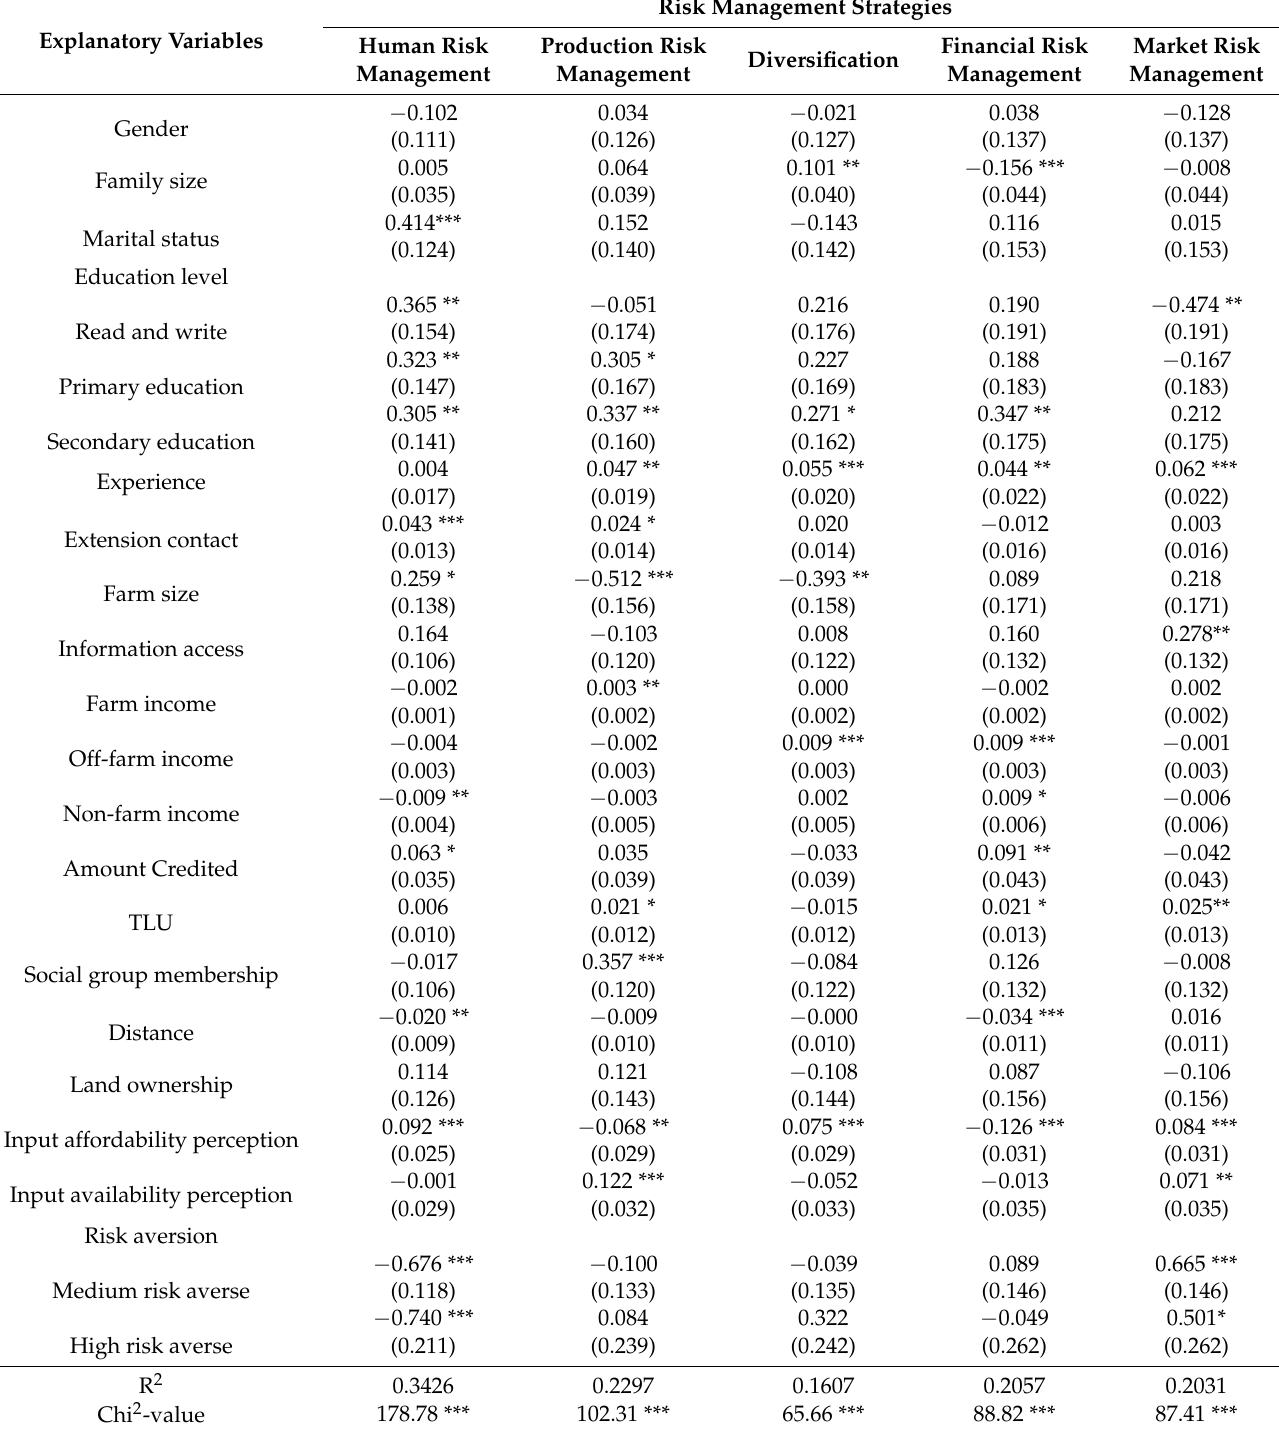
Table 4. SUR model result for predictors of input risk management